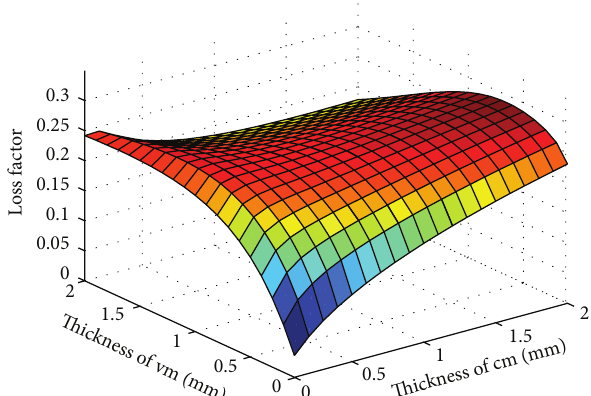
Figure 16: Influence of thickness on the loss factor in 5-layer struc- ture.